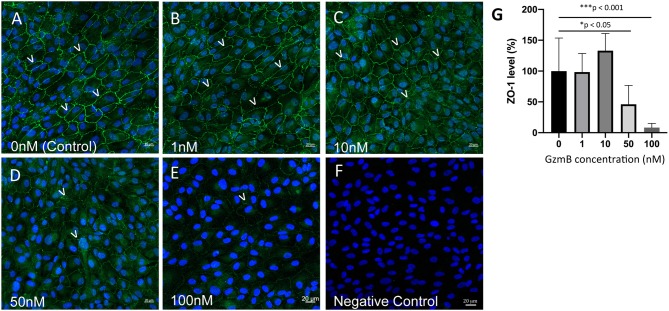
Reduced immunoreactivity of ZO-1 in ARPE-19 cells stimulated by exogenous GzmB. (A–E) Note immunoreactivity of ZO-1 tight junctional contacts (green, 488 nm) between cells (some shown by white arrowheads) is reduced with increasing concentrations of GzmB (1, 10, 50, 100 nM) for 6 h. (F) Omission of primary antibody demonstrates lack of green ZO-1 immunolabeling. (G) Significant differences were observed between controls and 50 and 100 nM GzmB. A one-way ANOVA and Tukey's multiple comparisons post-hoc test (N = 6 per group) were used to compare control group with GzmB-treated groups: mean ± SEM; *p < 0.05; ***p < 0.001. DAPI (405 nm) labeling of nuclei is shown in blue. Scale Bar = 20 μm.